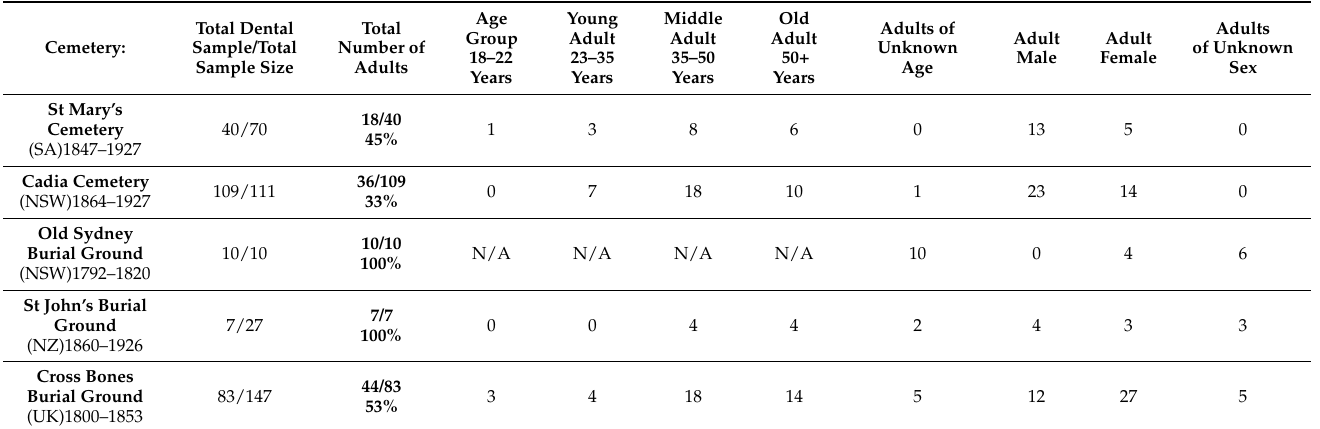
Table 9. Demographic profiles of the adults from St Mary’s Cemetery, SA; Cadia Cemetery, NSW; Old Sydney Burial Ground, NSW; St Johns Burial Ground, NZ; and Cross Bones Burial Ground, UK.